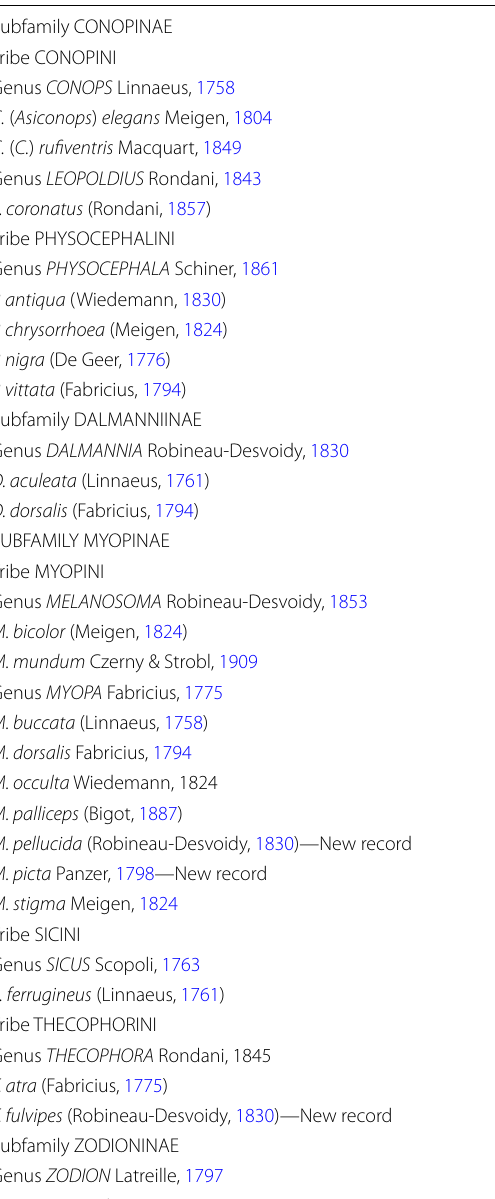
Table 1 Conopid taxa recorded from Algeria Subfamily